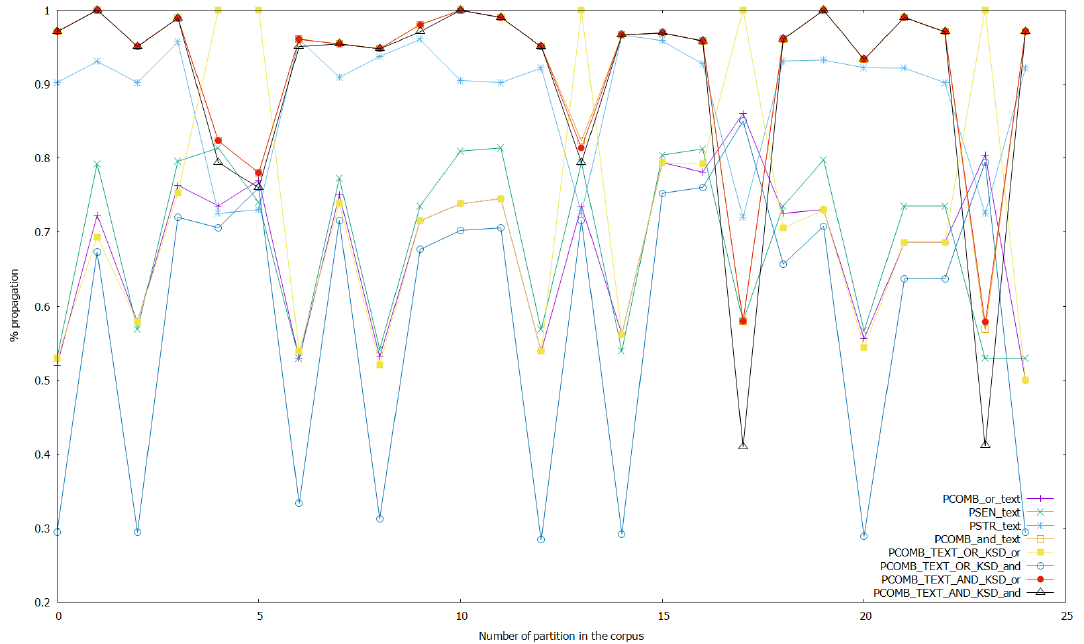
Figure 6. Results of the experiments with the sentiment, stress, and combined analyses on text, and with the combined analyses on text and keystroke data with threshold set to 0.7 in the ANNs that work with keystroke data.